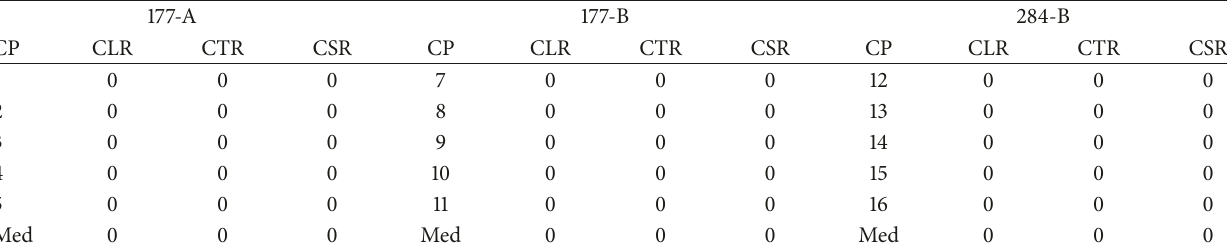
Table 5: HIC test results for the API 5L X52MS steel.